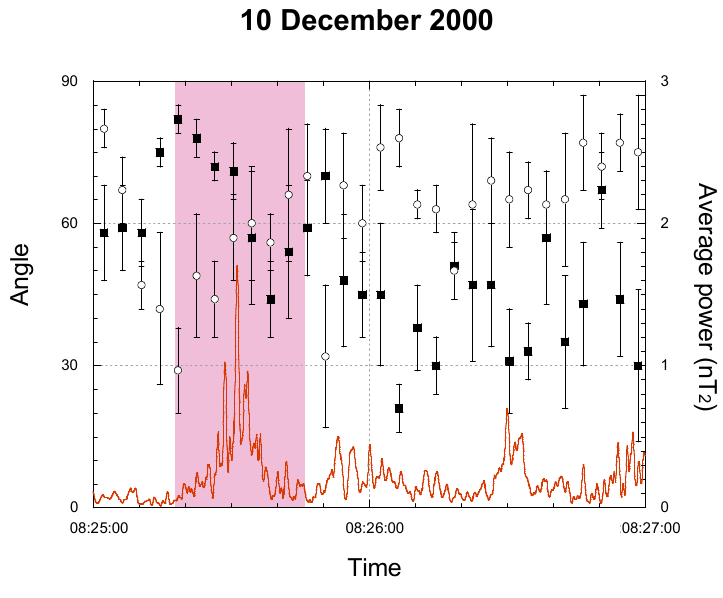
Fig. 6. MVA results for 0.35Hz fluc- tuations for crossing 2. The points are the values of the angles between B 0 and the direction of maximum variance ( ) and minimum variances ( ◦ ) averaged on the four spacecraft. The error bars are the mean square differences of the four values with this average. The position of the magnetopause is shown by the shaded zone and the average power of the fluctuations is drawn for compari-